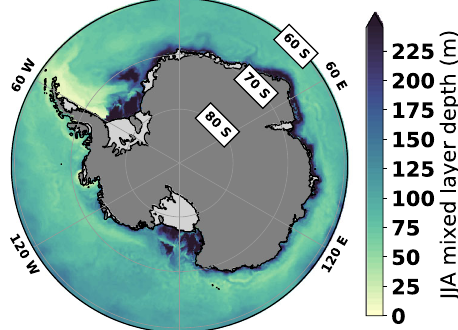
Fig. 6 Winter mixed layer depth in the CTRL run. Map of the winter (JJA) mixed layer depth in the CTRL run. Values are averaged over years 25 to